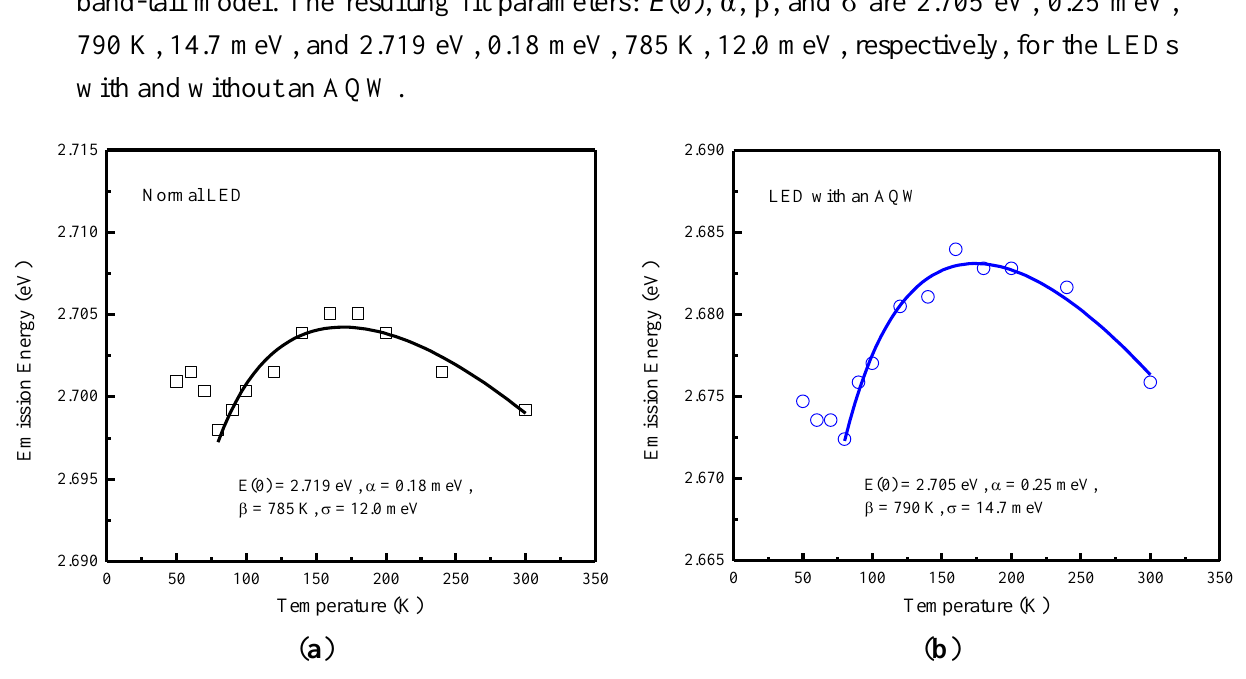
Figure 4. Light output power as a function of injection current for the LEDs with and without an AQW at 300 K. The inset shows the current-voltage (I-V) characteristics of the fabricated InGaN